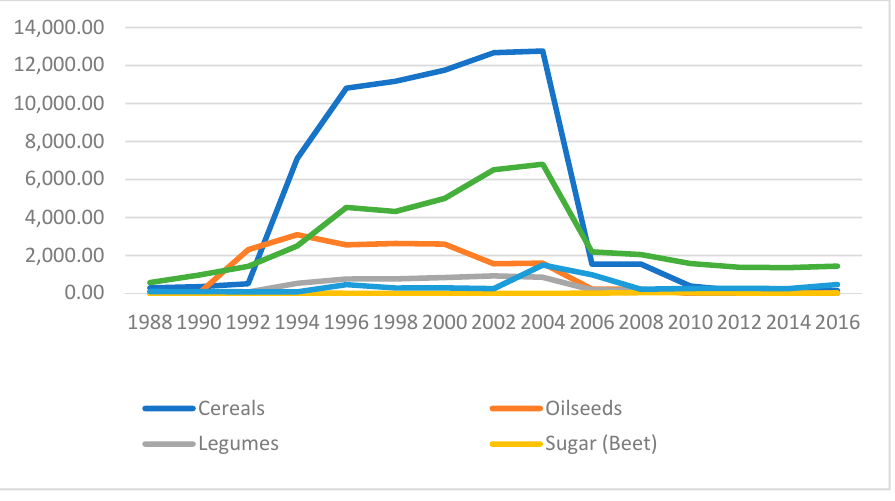
Figure 1. Production aid for continental products 1988-2016 (millions of euros). Source: own elaboration based on data obtained from EUROSTAT.